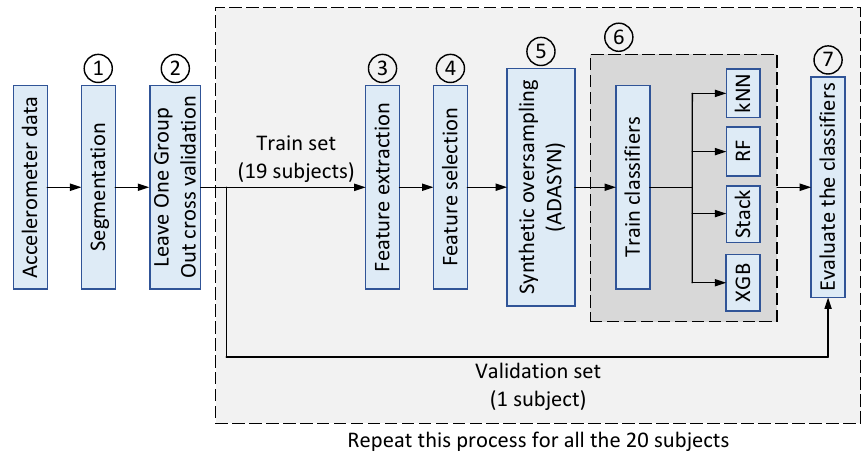
Figure 3. Flowchart of the proposed approach. The numbers correspond to the steps in Section 2.7.